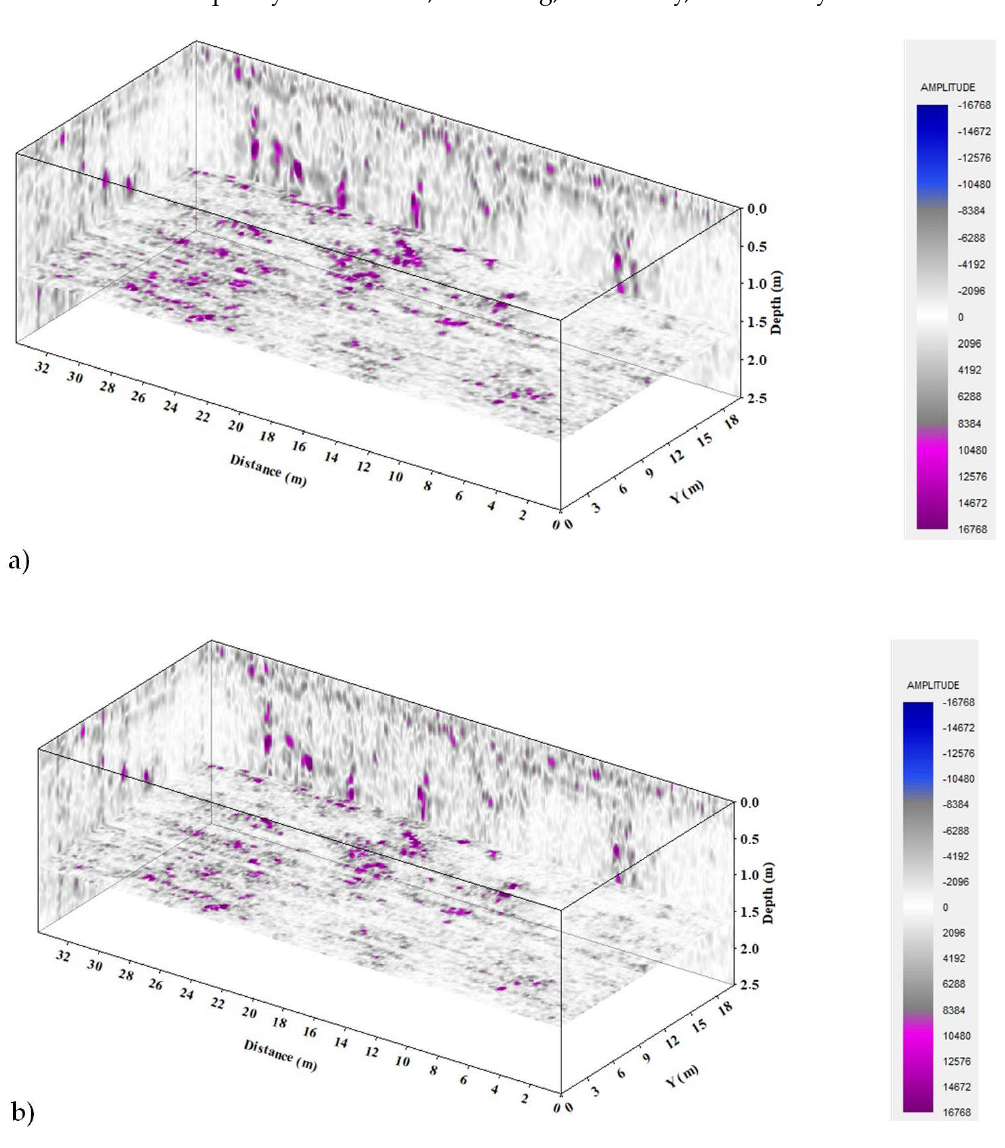
Figure 6. Horizontal depth slices depicting the envelope at a depth of 1.6 m after multipath summation ( a ) and after time-varying spectral whitening ( b